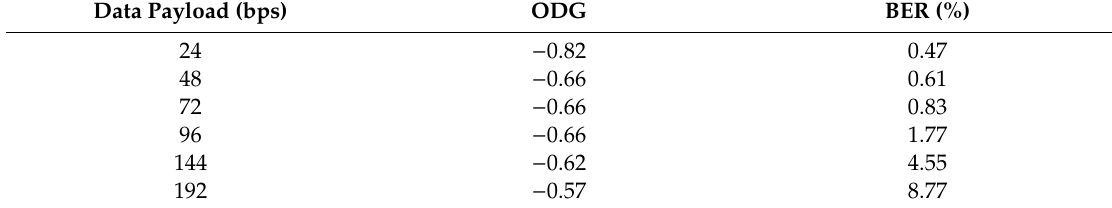
Figure 9. ODG and BER values under various data payloads.